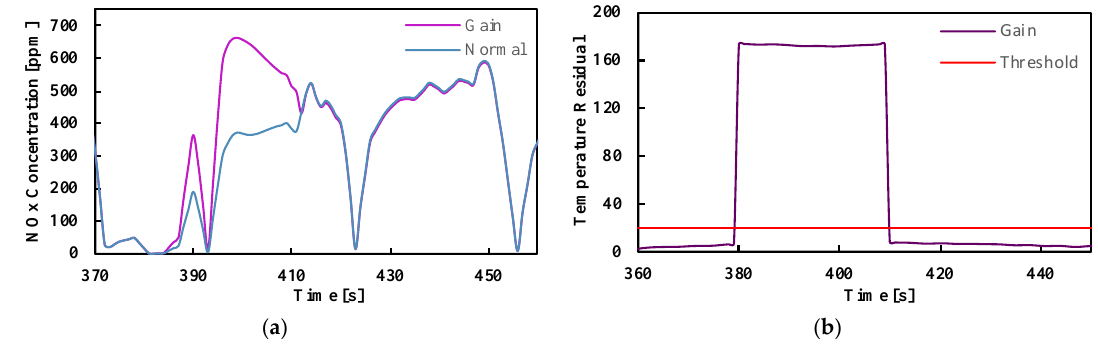
Figure 13. Fault detection and fault-tolerant control performances. ( a ) NO x concentration; and ( b ) temperature residual.